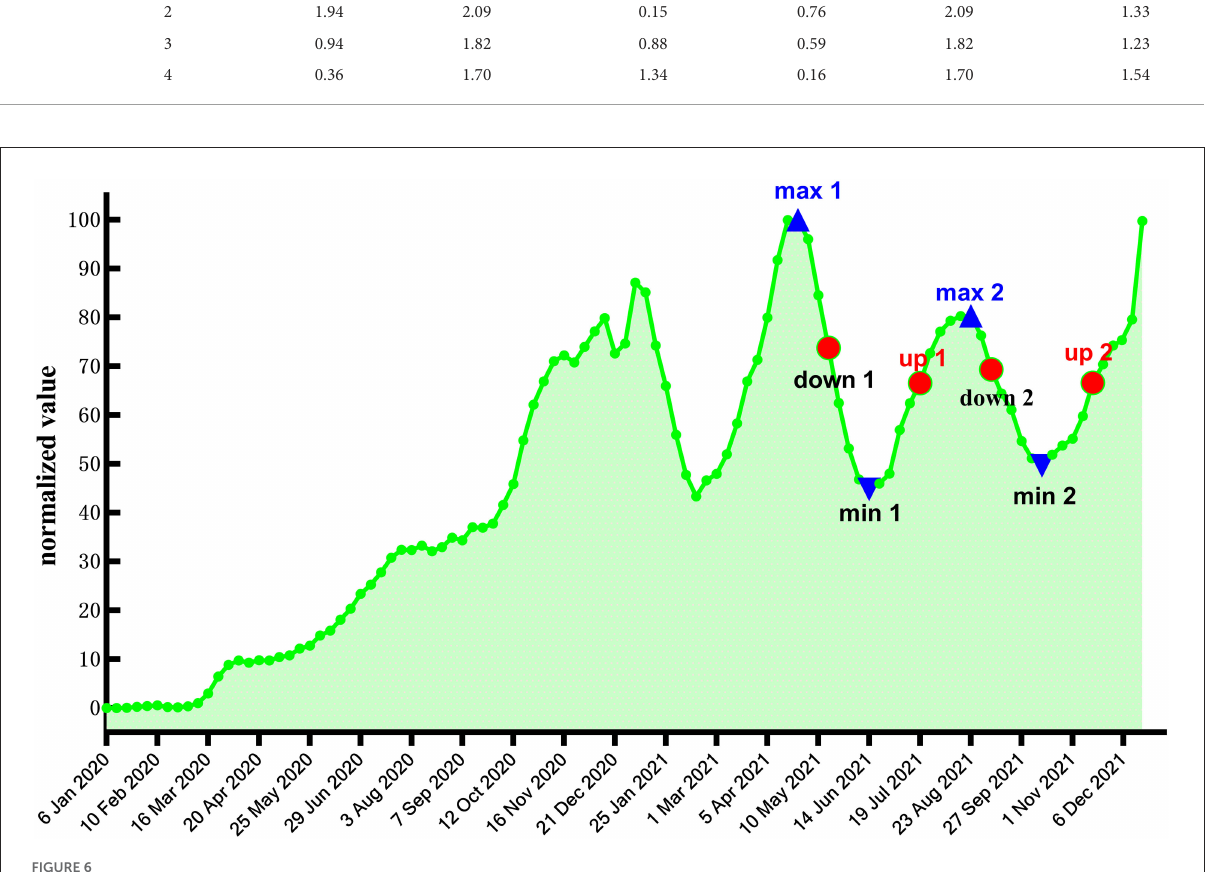
FIGURE6 Timing diagram of weekly new confirmed cases